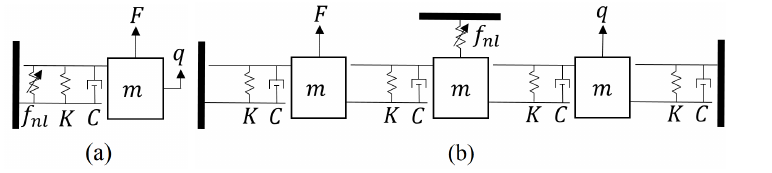
Figure 2. Discrete system benchmark problems ( a ) SDOF, ( b ) MDOF with one nonlinear element.